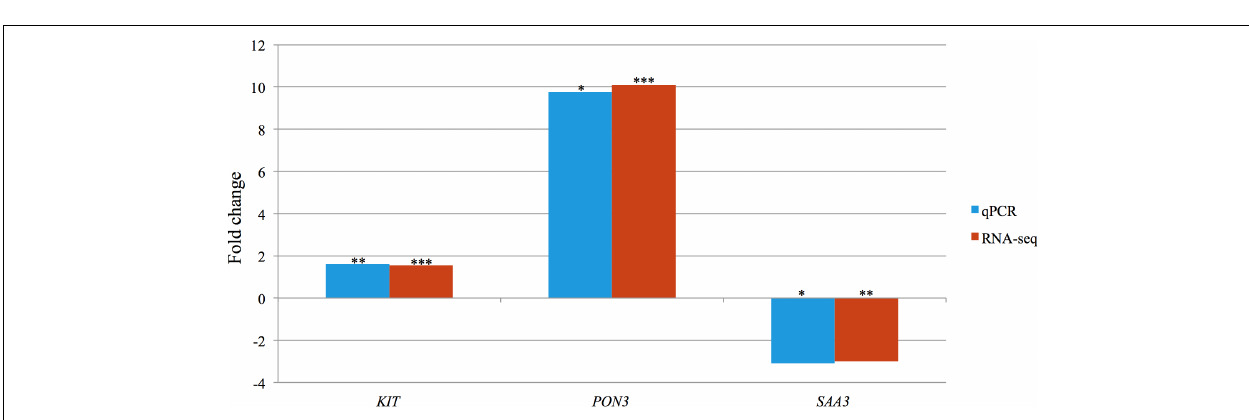
FIGURE 4 | Bar chart portraying the RNA-seq and qPCR fold changes of three selected differentially expressed genes in high-FE pigs. Significance levels of differences affected by feed efficiency: ∗ P < 0.05, ∗∗ P < 0.01, ∗∗∗ P <